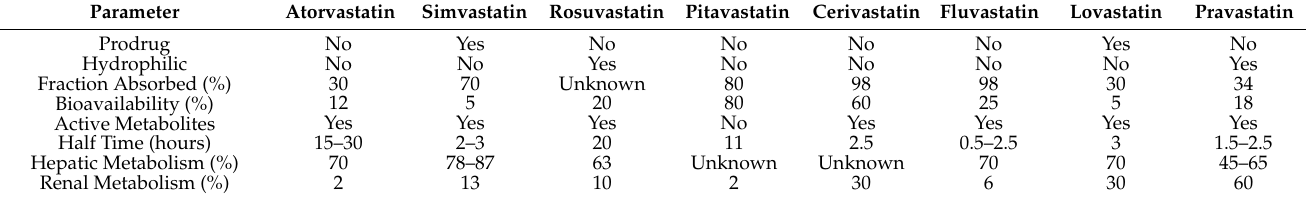
Table 1. Pharmacokinetics features of commonly used statins (adapted from Askarizadeh et al. [14]). Parameter Atorvastatin Prodrug